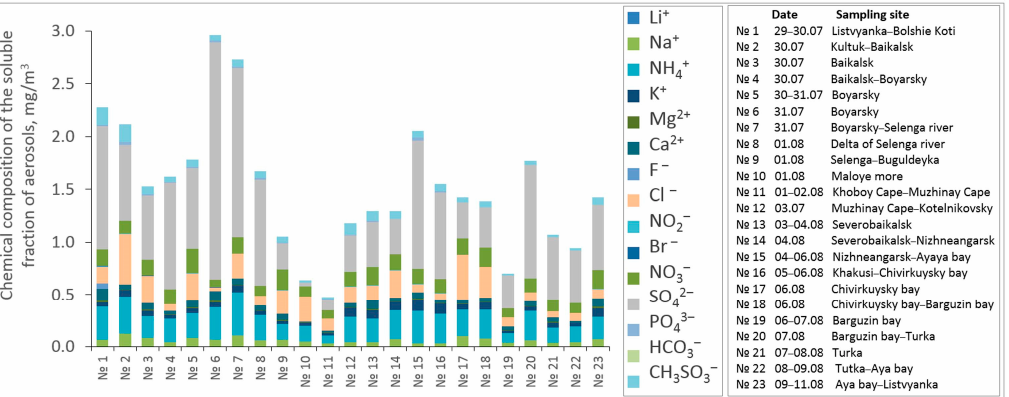
Figure 3. Concentrations of soluble ions in the aerosols along route of the research vessel “Acade- mician V.A. Koptyug”. cian V.A.